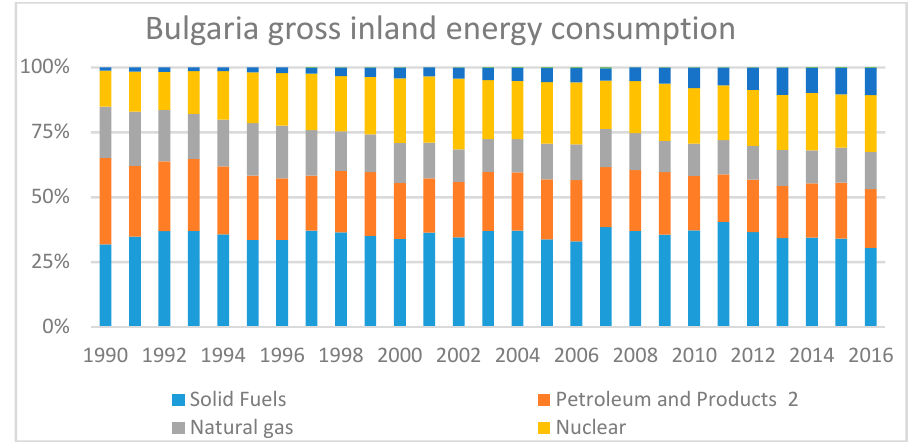
Figure 10. Gross inland energy consumption structure dynamics in Bulgaria, %. Source: [40].